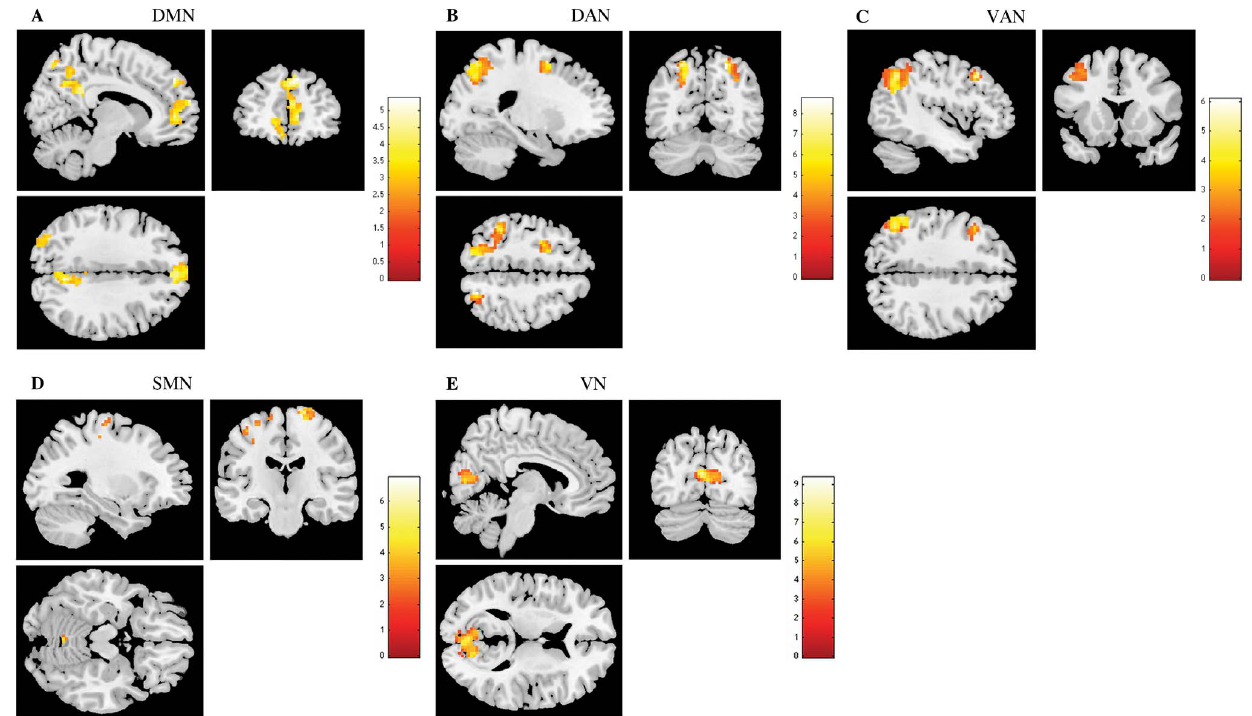
Figure 2. The impact of stress in Resting State Networks (RSNs) at rest. The images depict areas in which stress participants display greater activity than controls in the default mode network (DMN) (A), dorsal attention network (DAN) (B), ventral attention network (VAN) (C), sensorimotor network (SMN) (D) and visual network (VN) (E), extracted by independent component analysis and using two-sample t-tests, with results considered significant at a corrected for multiple comparisons p , 0.05 threshold. Noticeable, there were no areas of increased activation of these RSNs in controls than in stress individuals.